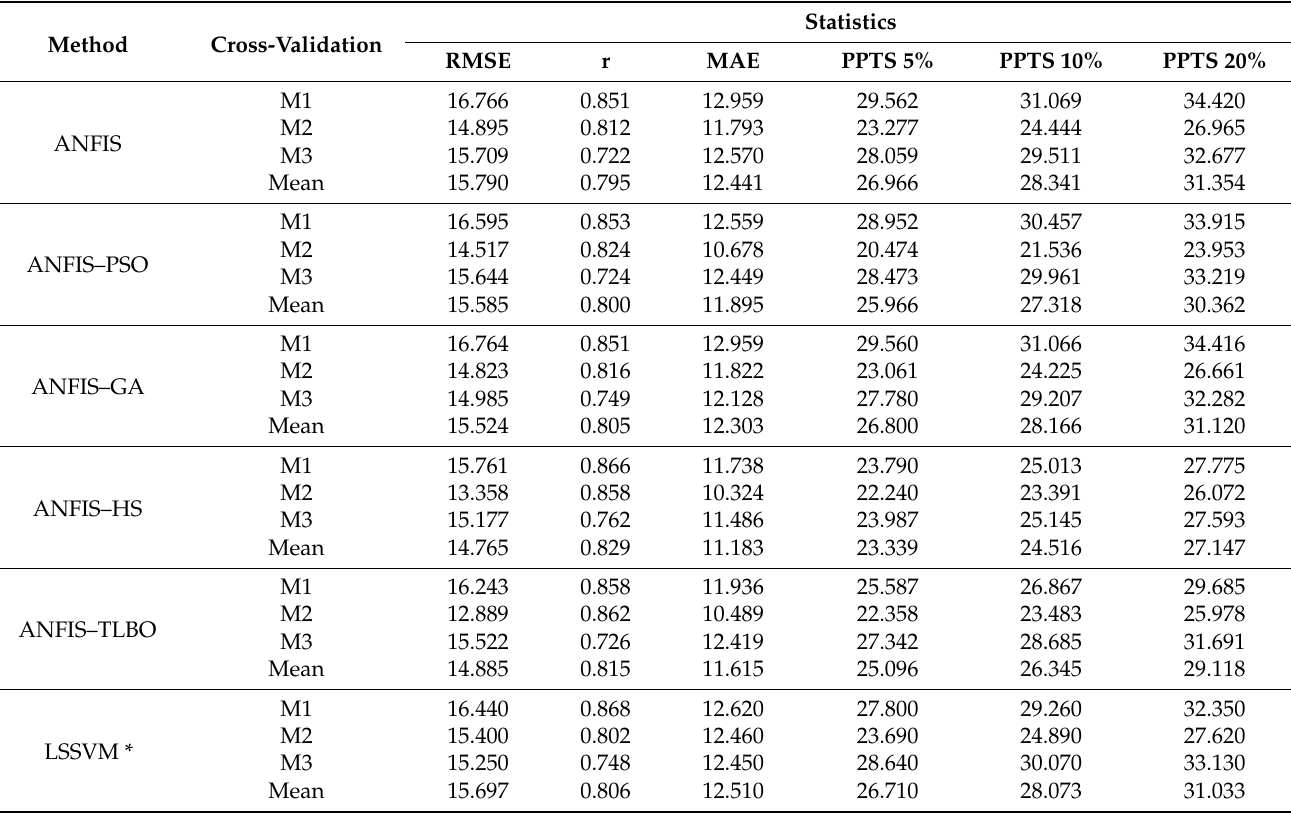
Table 7. Comparison of the applied models with AMM, TKN, WT, TC, and FC as